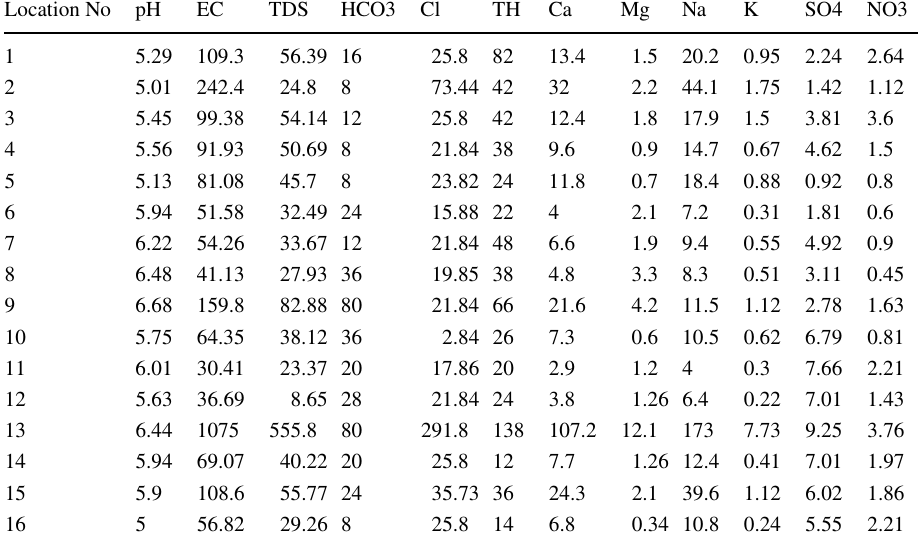
Location No pH EC